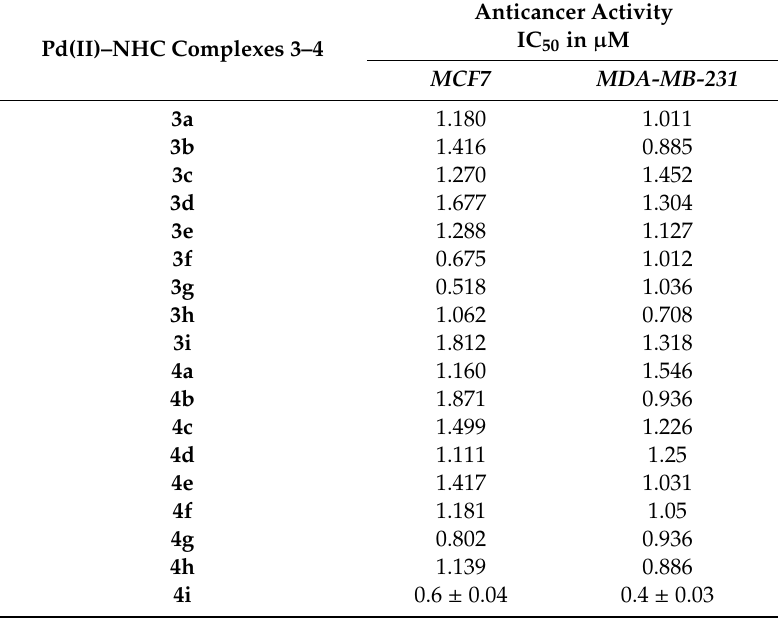
Table 1. Anticancer activity of Pd(II)–N-heterocyclic carbene (NHC) complexes 3–4